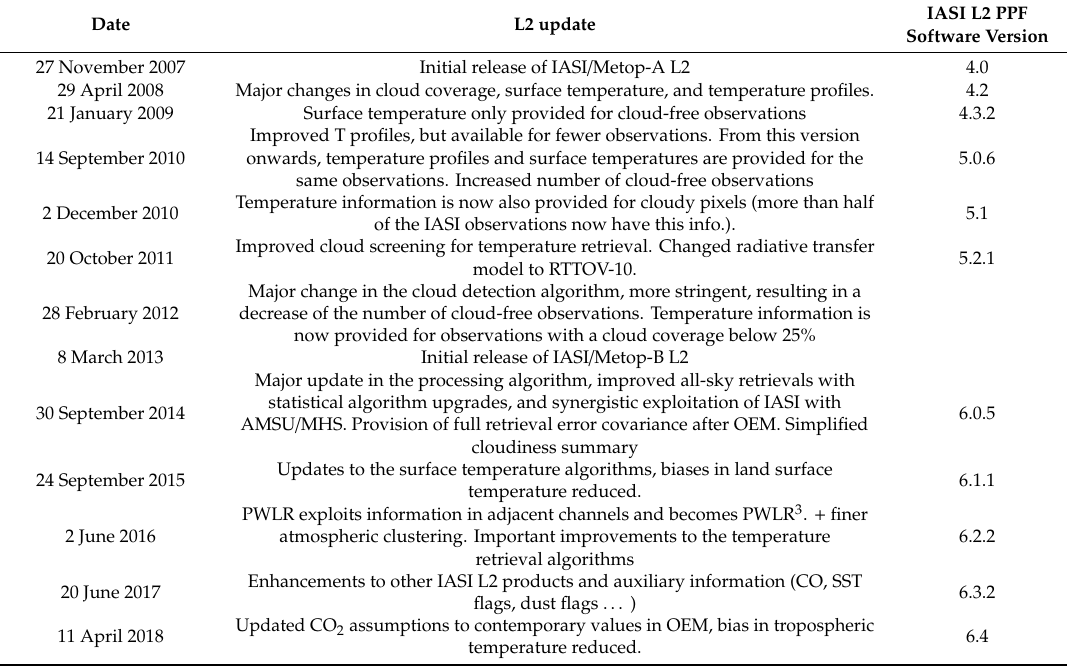
Table 2 lists the main updates of the L2 algorithm. Table 2. List of IASI L2